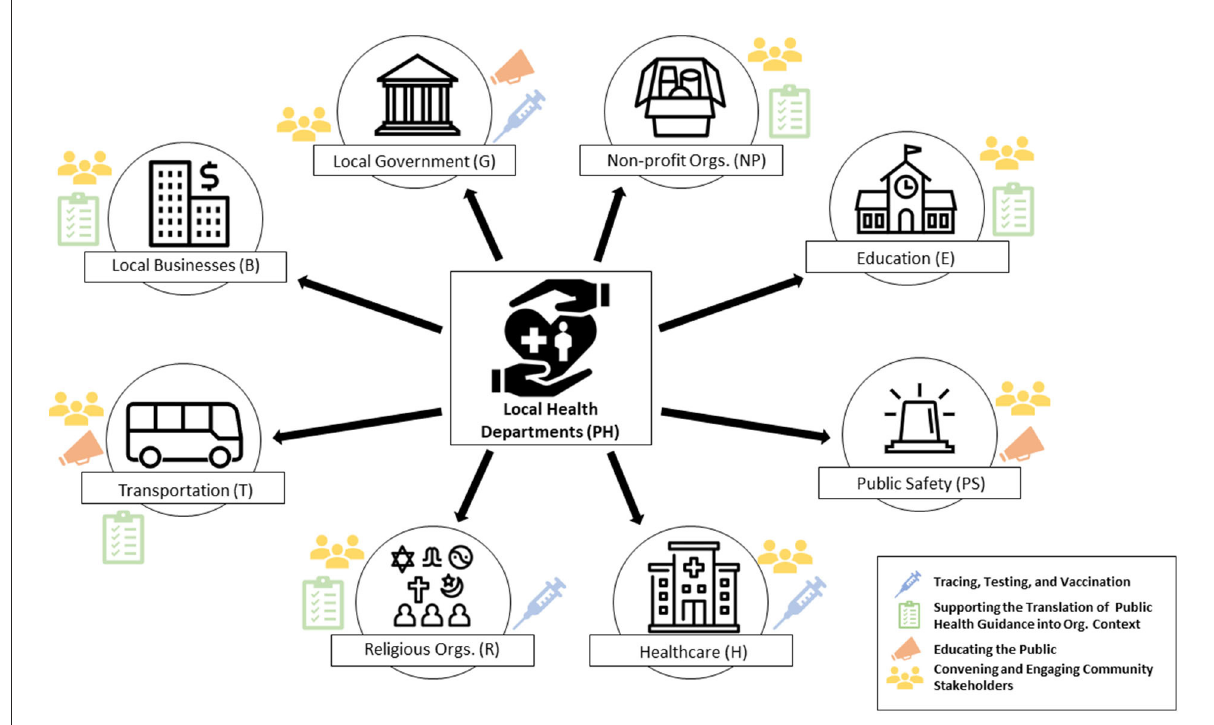
FIGURE2 Central roles of local health departments in coordinating local COVID-19 pandemic response across